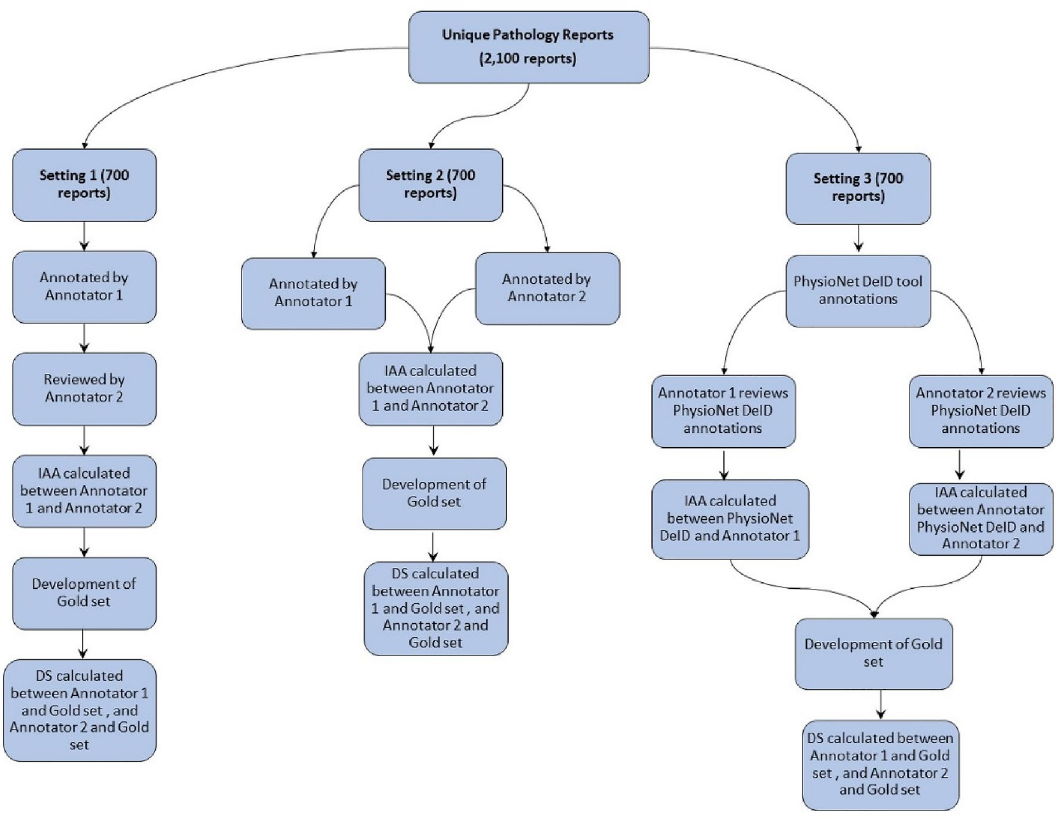
Figure 2. Annotation process under three different